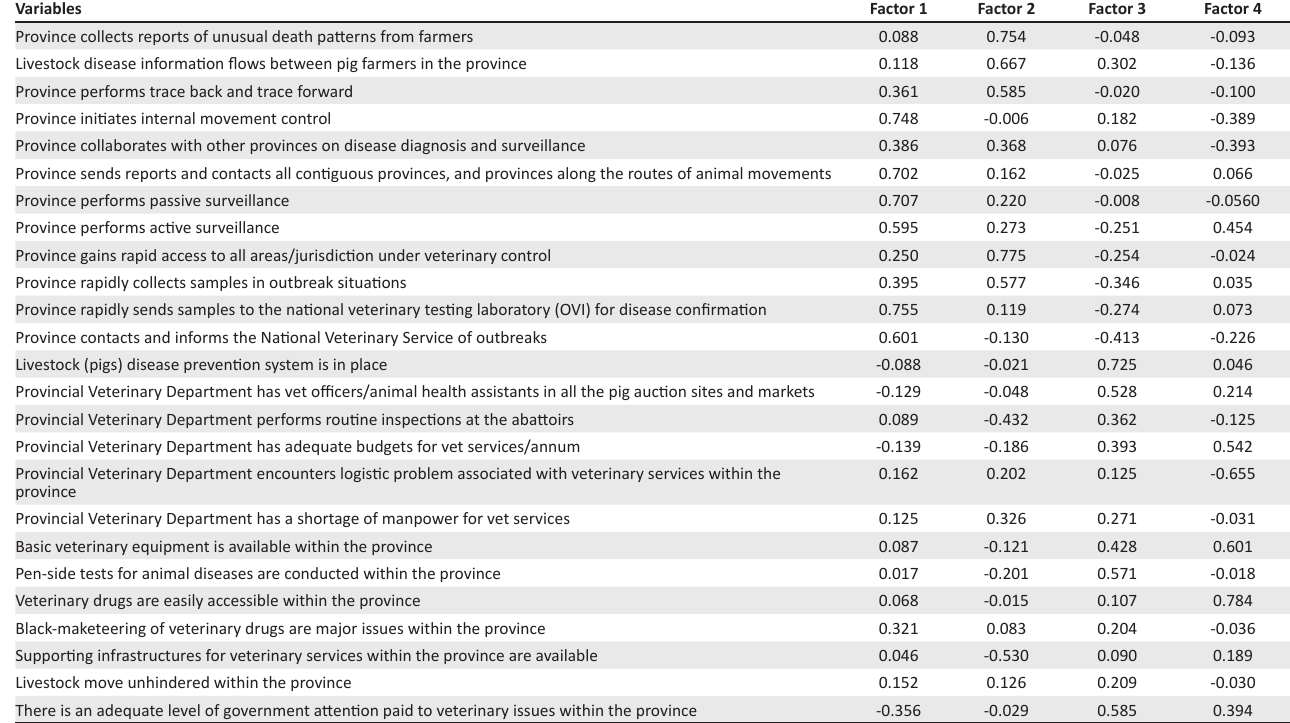
TABLE 2: Factor analysis of the latent variables and their corresponding indicators using Rotated Factor Loadings (Varimax).